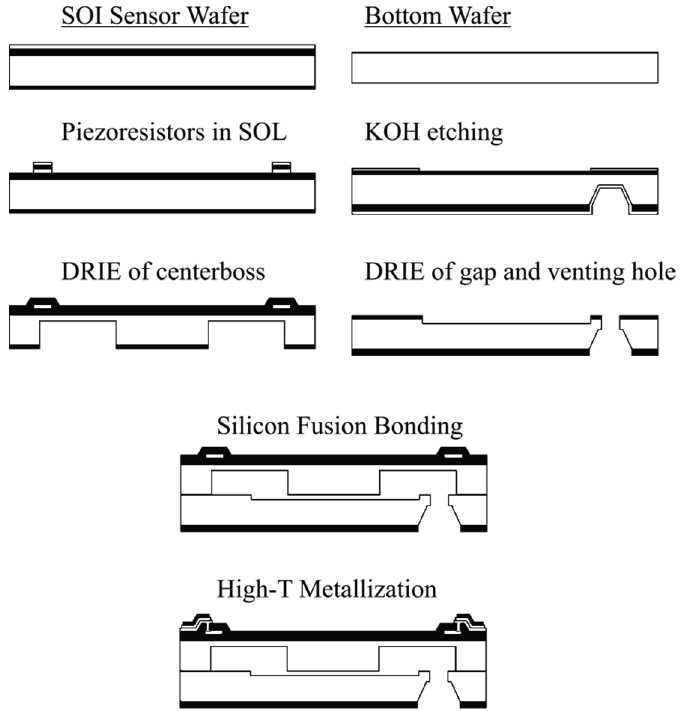
Figure 4. Process flow for sensor fabrication. Piezoresistors and membrane with centerboss are fabricated in SOI wafer. Gap and venting hole are fabricated in Si bottom wafer. SOI and bottom wafers are bonded by using silicon fusion bonding